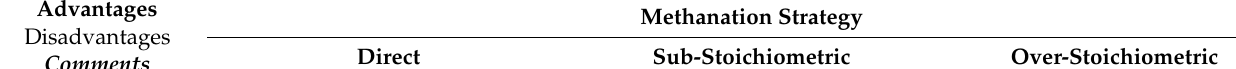
Table 8. Overview of advantages and disadvantages of the applied methanation strategies on different syngas compositions.